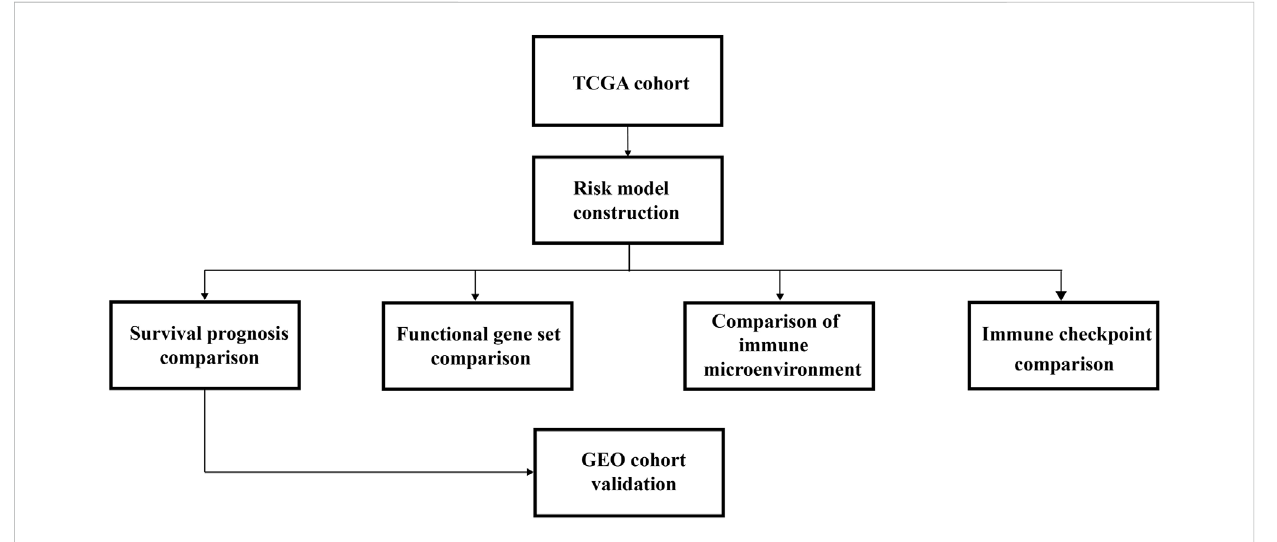
FIGURE 1 Diagrammatic representation of the analytical process used in this